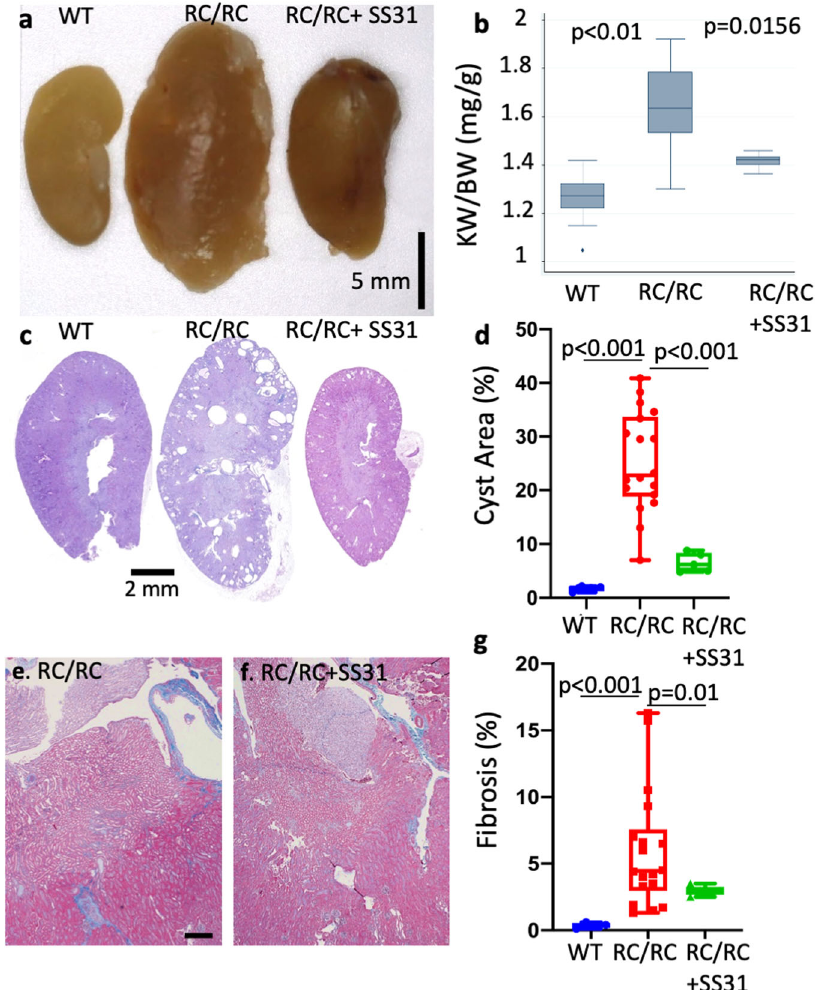
Fig. 7 SS31 exerts a protective effect in RC/RC kidneys. a Gross pathology b normalized kidney weight from WT, RC/RC, and RC/RC mice treated with SS31. c Representative PAS staining of kidney sections. d Quantitative analysis of cysts area. e , f Higher magni fi cation of trichrome staining of kidney sections from RC/RC and RC/RC mice treated with SS31 (scale bar: 100 µ m). g Quantitative analysis of trichrome blue area; n = 5 −